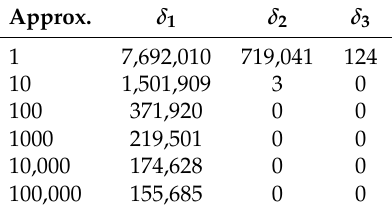
Table 6. Number of skipped columns of the coboundary matrix for an Erd˝os-Rényi graph with respect to different values of the Approximate parameter in dimensions from 1 to 3. Approx. δ